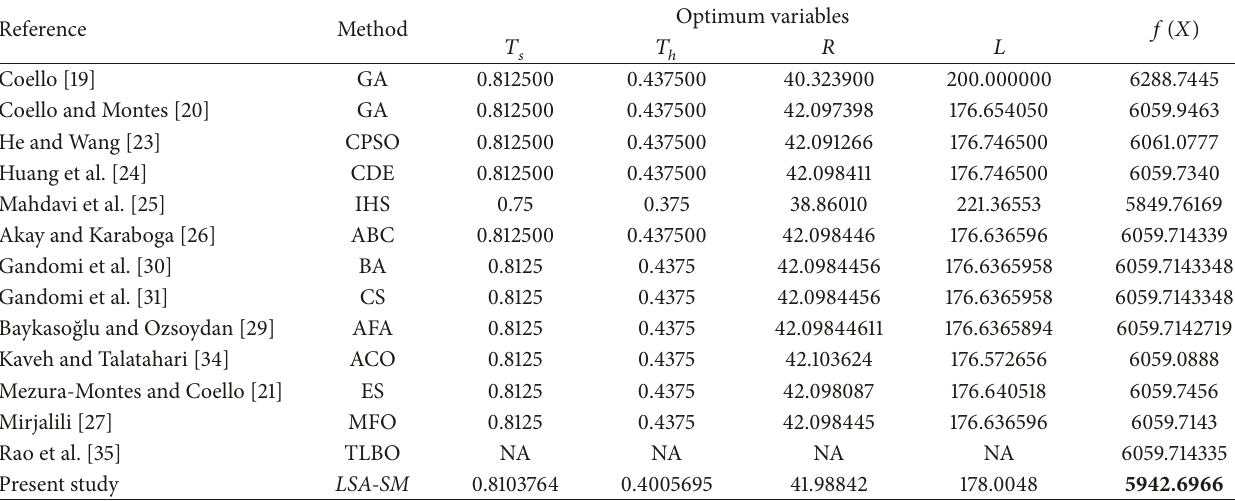
Table 10: Best results of the pressure vessel design by different